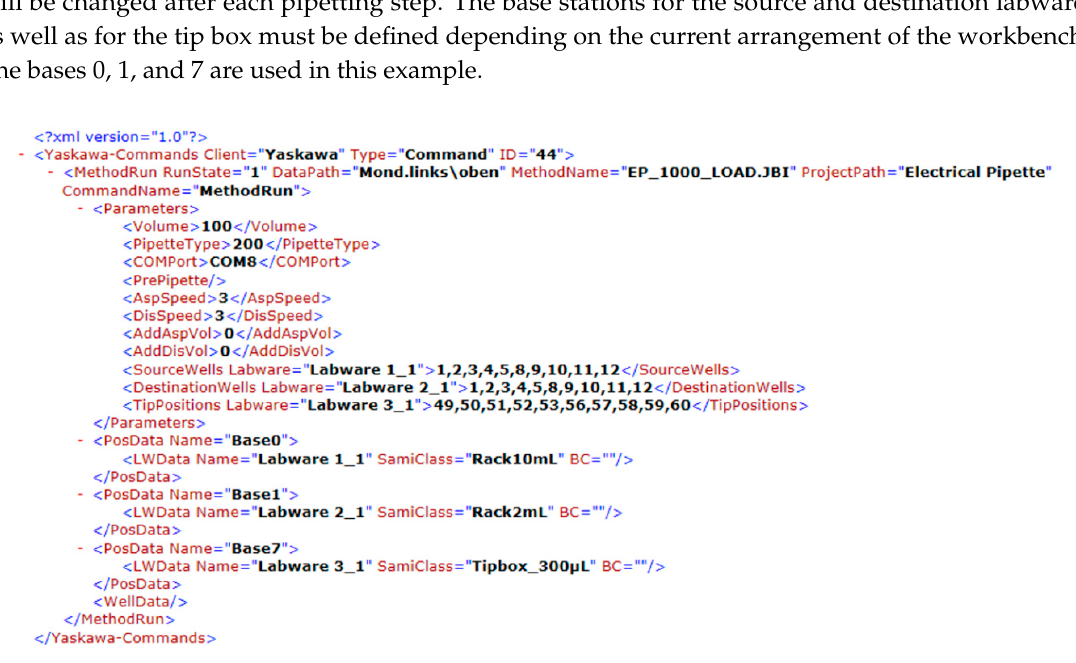
Table 7. Measurement results of pipetting 100 µL using manual and electronic pipettes.